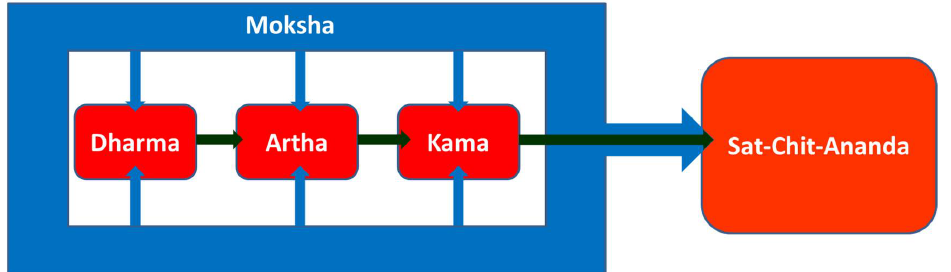
Figure 1. Purushartha: the four objects of life (please see text for description). Dharma is the way of securing artha and artha is the means of kama. Dharma, artha, and kama are the essential objects of life. Moksha clears ignorance and enhances the capability of realizing the other three (mainly dharma) to their full potential. On achieving complete moksha, the other three can be realized to the maximum, which leads to the extension of the pleasure of life (kama) to the Sat-Chit-Ananda (sustainable happiness).